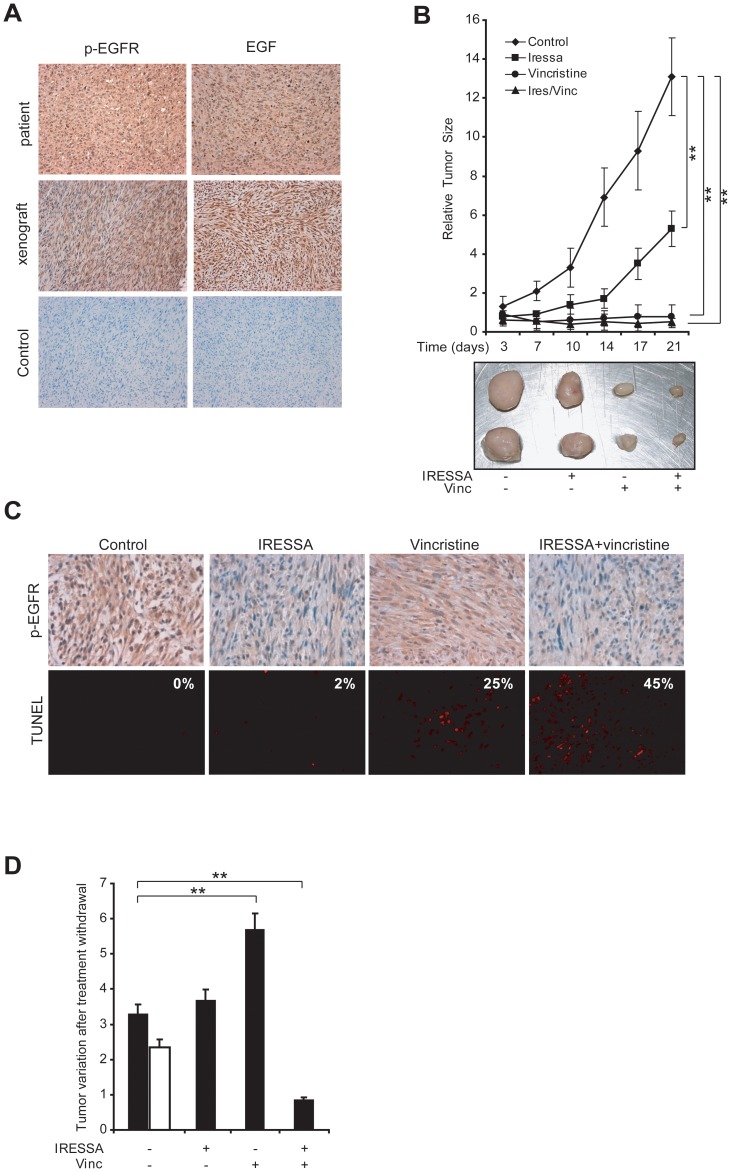
IRESSA/Vincristine treatment results in strong stem-like cell-effective anti-tumor activity in patient tumor phospho-copies generated by LMS-stem-like cells.A) LMS stem-like cells derived xenografts display high levels of EGF and p-EGFR similarly to the patient tumor. A) EGF and p-EGFR immunohistochemistry in patient tumor specimens and in LMS-CSC derived xenografts. B) Tumor growth curves and tumor pictures of LMS-CSC derived xenografts in control, IRESSA-, Vincristine- or IRESSA+Vincristine- treated mice. Mean ± SD of 3 independent experiments is shown. **p<0,01. C) p-EGFR immunohistochemistry and TUNEL assay of control or treated xenografts. The percentage of Tunel positive cells is indicated for each condition. D) Tumor growth rate of control or pre-treated tumors after treatment interruption. Pre-treated tumors were monitored after 10 days and tumor growth is indicated as ratio of tumor volume at day10 vs day0.The white bar represents growth rate of additional control tumors comparable to treated tumors in size. Mean ± SD of 3 independent experiments is shown. ** p<0,01.